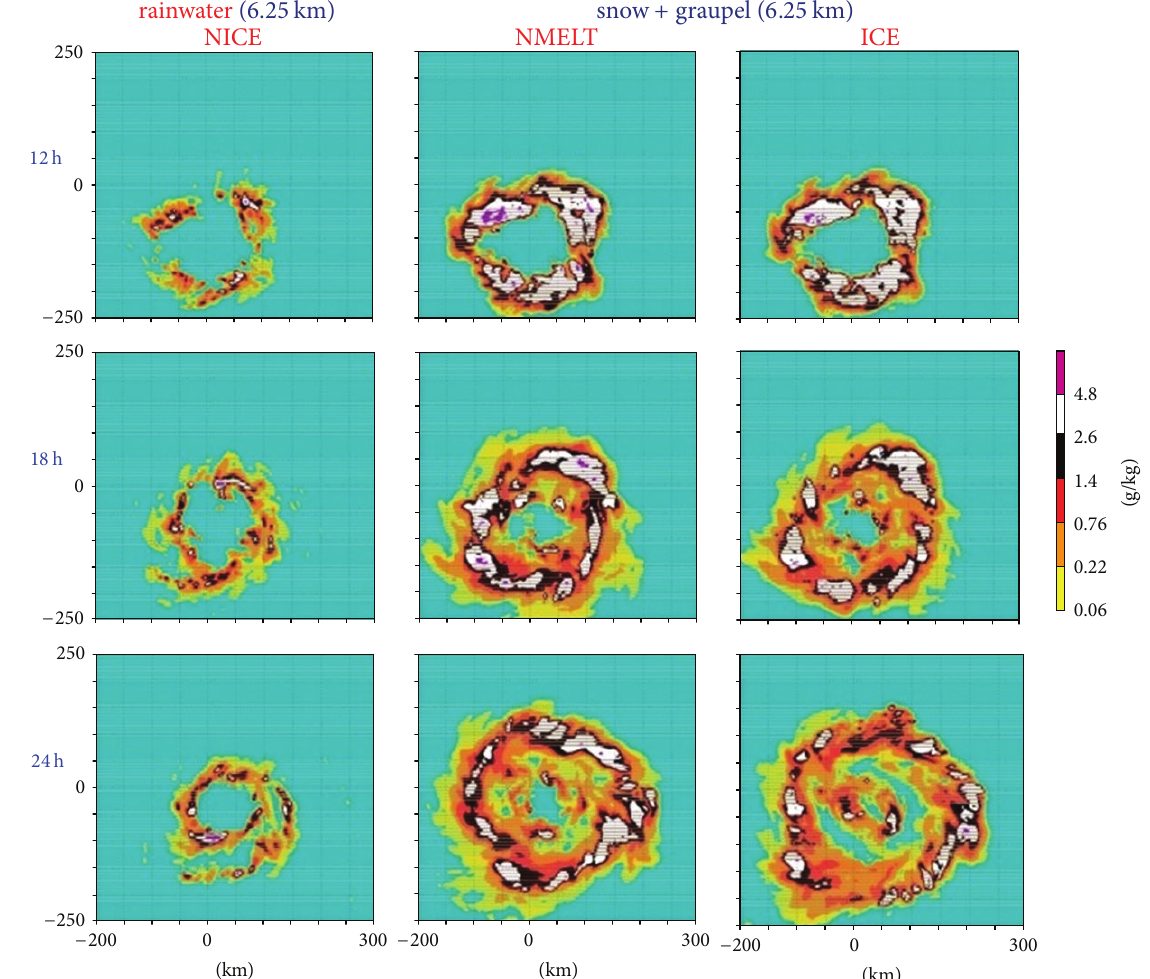
Figure 3: Comparison of the mixing ratio of precipitating substance; rainwater in case NICE, and the sum of snow and graupel at 6.25 km height at 12h, 18h, and 24